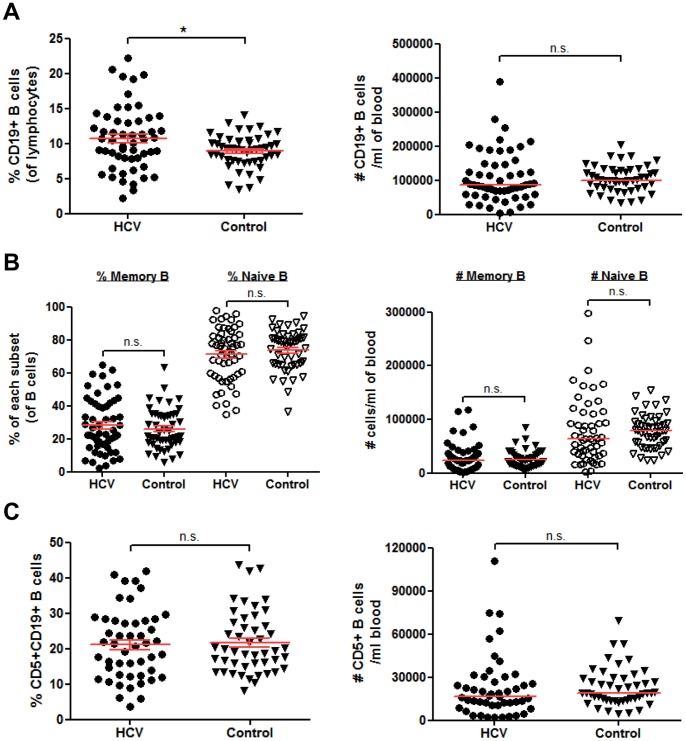
B cell subset frequencies are unchanged in HCV patients compared to controls.(A–C) 7.5×105 freshly isolated PBMCs from chronically infected HCV patients (n = 54) or healthy controls (n = 50) were incubated with fluorescently labeled antibodies to CD19, CD27 and CD5 for multi-color flow cytometry analysis. (A) The total percent of CD19+ B cells within the lymphocyte gate and number of B cells per ml of blood based on our isolations. (B) The percent of memory (CD19+CD27+) and naïve (CD19+CD27−) and number of each subset per ml of blood. (C) The percent and number per ml of CD5+CD19+ B cells. Horizontal lines on graphs represent means +/− SEM (percentages) or median (number of cells/ml) values. In (C) only 48 HCV and 47 healthy control samples were tested for CD5. *, P<0.05; n.s., not significant.